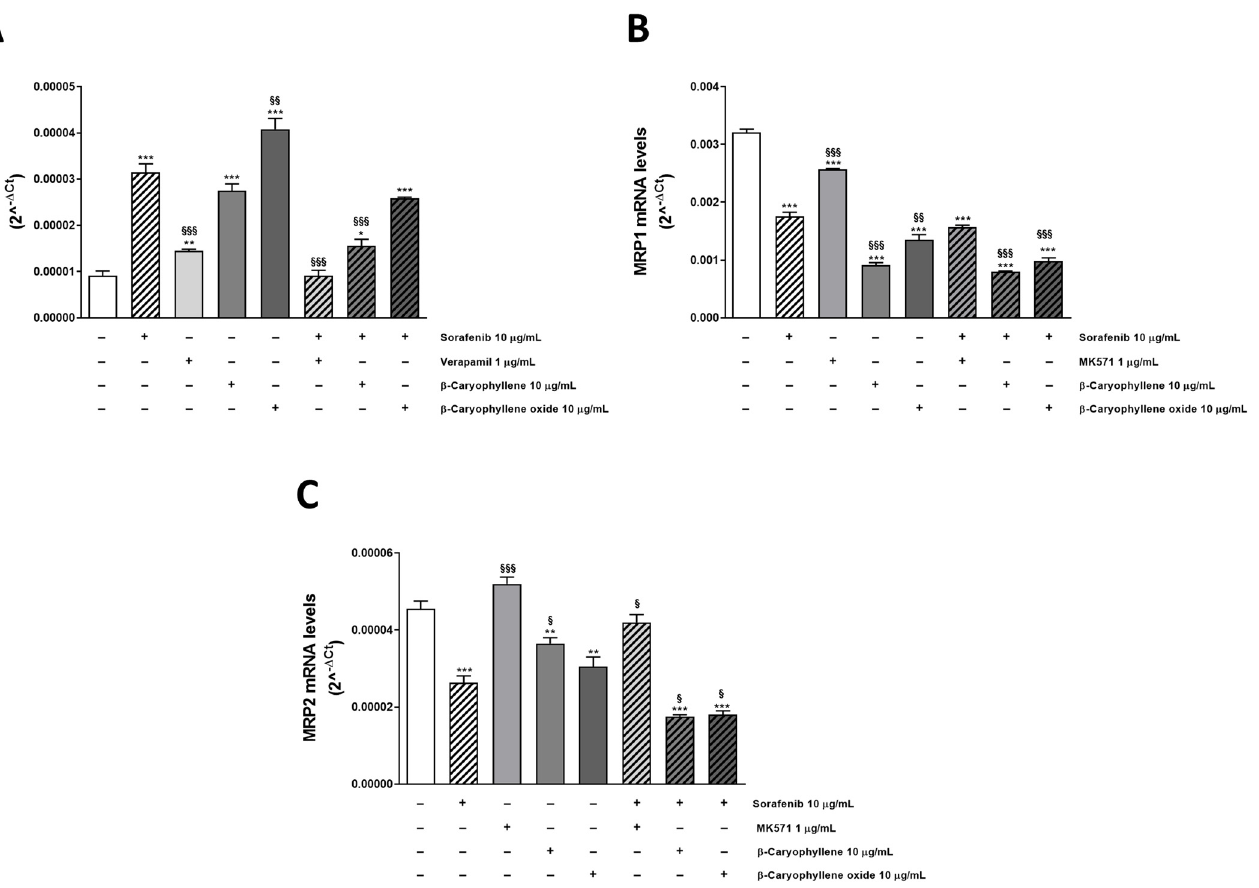
Figure 7. Relative mRNA expression of MDR1 ( A ), MRP1 ( B ), and MRP2 ( C ) in Bx-PC3 cells after treatment with sorafenib, verapamil, MK571, β -caryophyllene, β -caryophyllene oxide, and their combination with the anticancer drug after 4 h exposure and 72 h recovery time. * p < 0.05, ** p < 0.01 and *** p < 0.001 (one-way ANOVA followed by Dunnett’s multiple comparison post test) vs. control. § p < 0.05, §§ p < 0.01, and §§§ p < 0.001 (one-way ANOVA followed by Dunnett’s multiple comparison post test) vs. sorafenib alone.